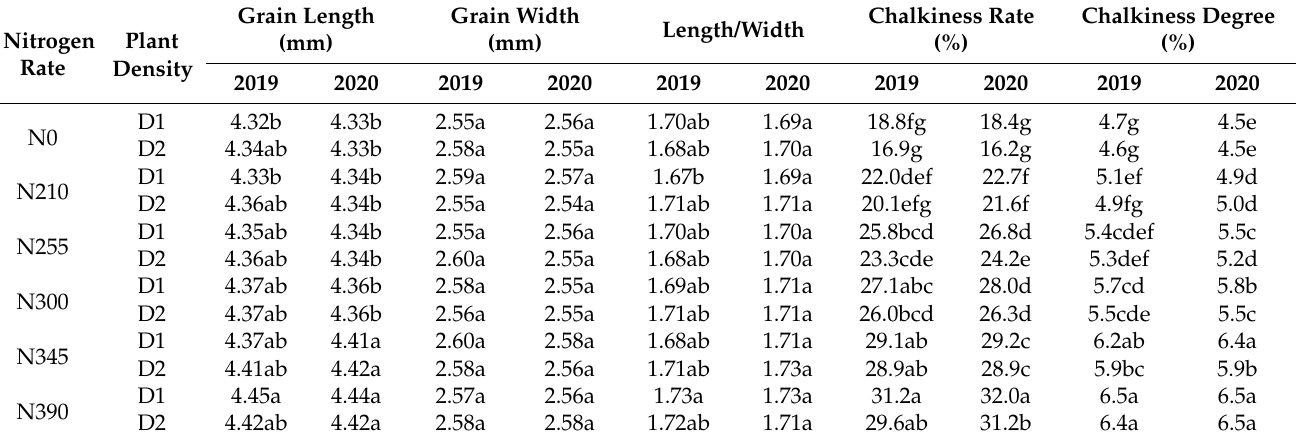
Table 5. Grain appearance quality under combined nitrogen rate and planting density in saline soil.